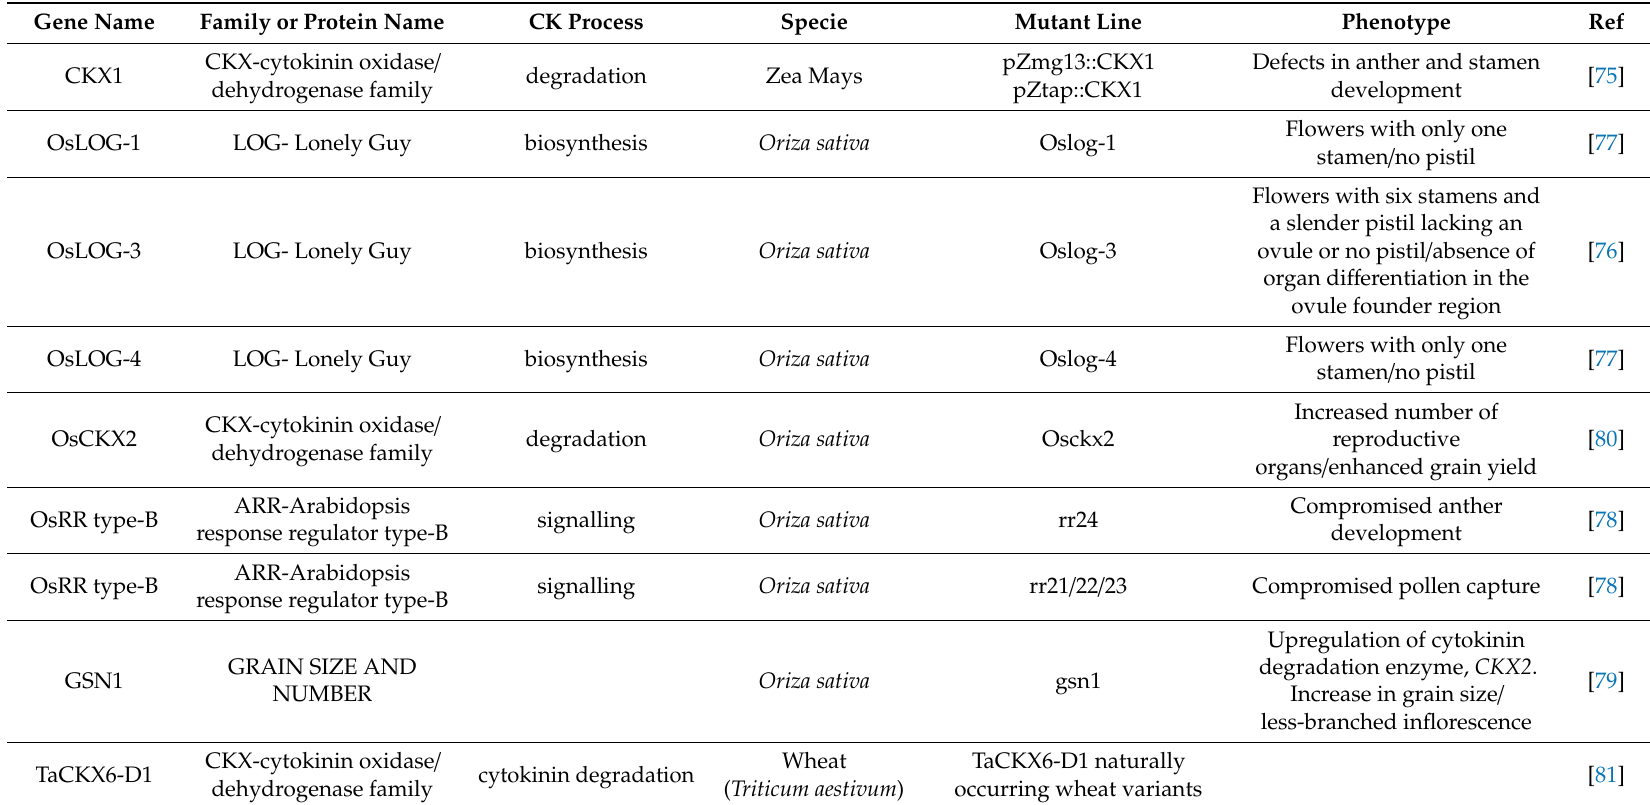
Table 2. Cytokinin-related mutants with reproductive development defects in crop